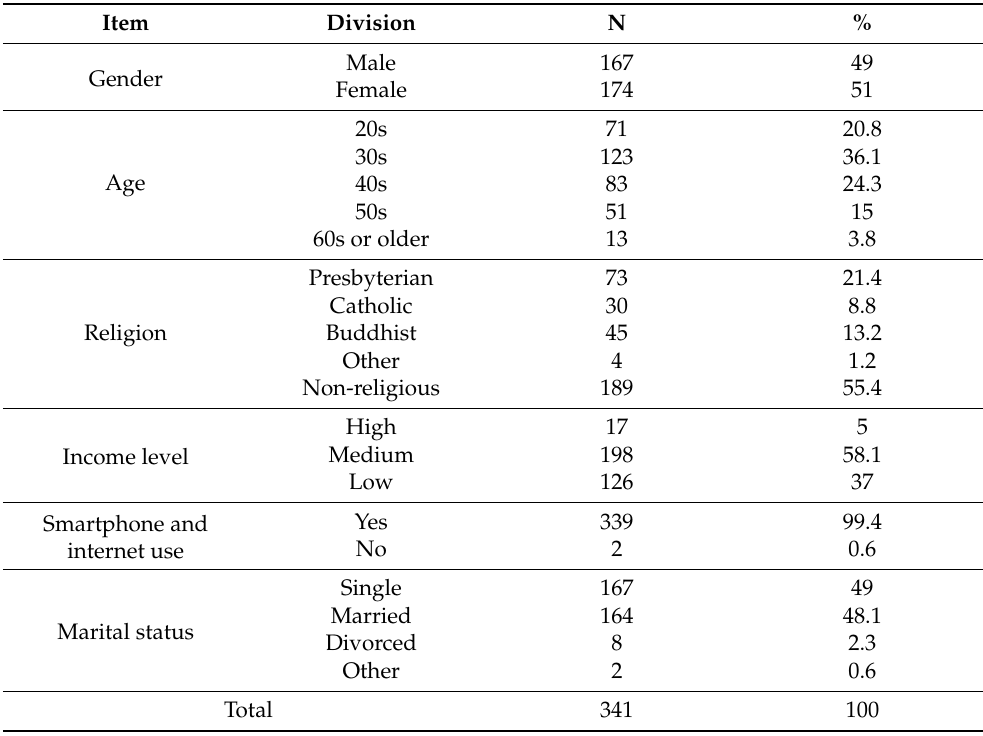
Table 1. General characteristics of the study